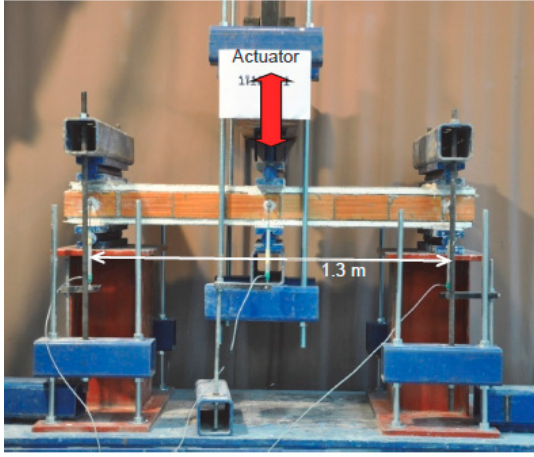
Figure 3. Experimental setup for out-of-plane testing.